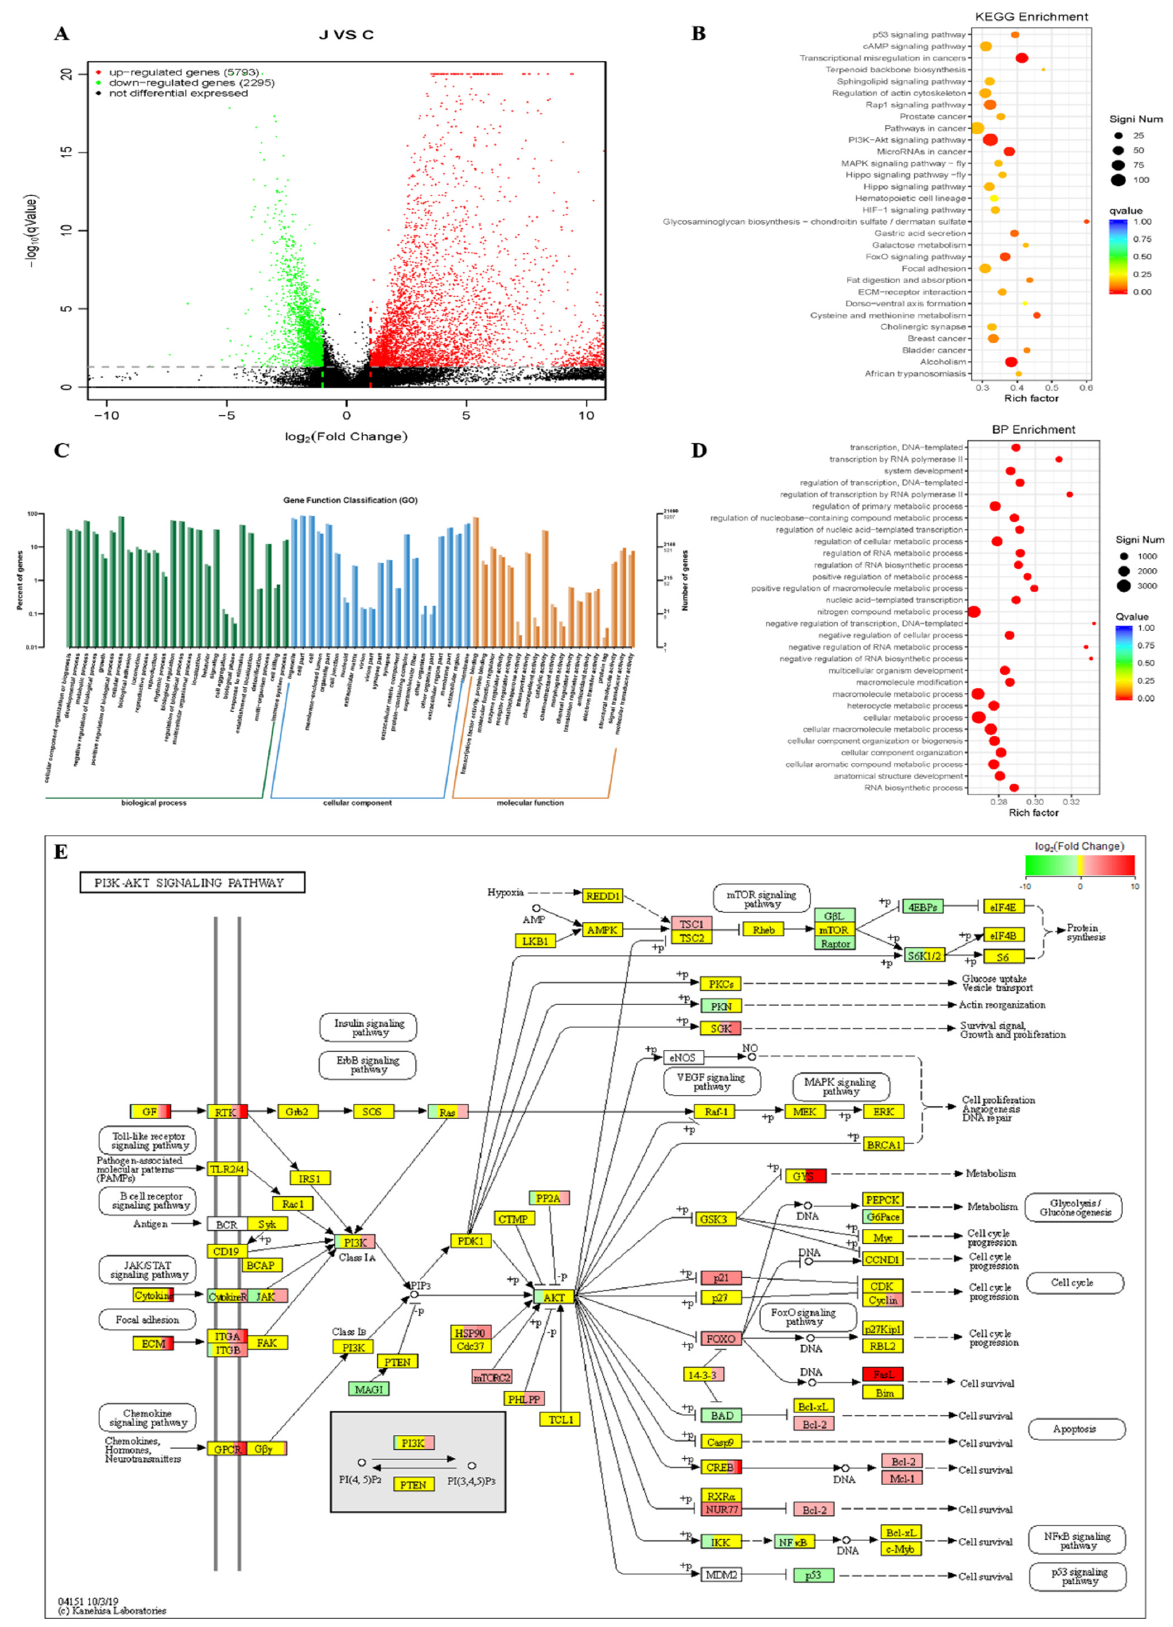
Figure 4. Transcriptome alterations of HepG2 cells were uncovered by high-throughput sequencing. ( A ) Volcano map showed significant differentiation of gene expression in HepG2 cells treated with